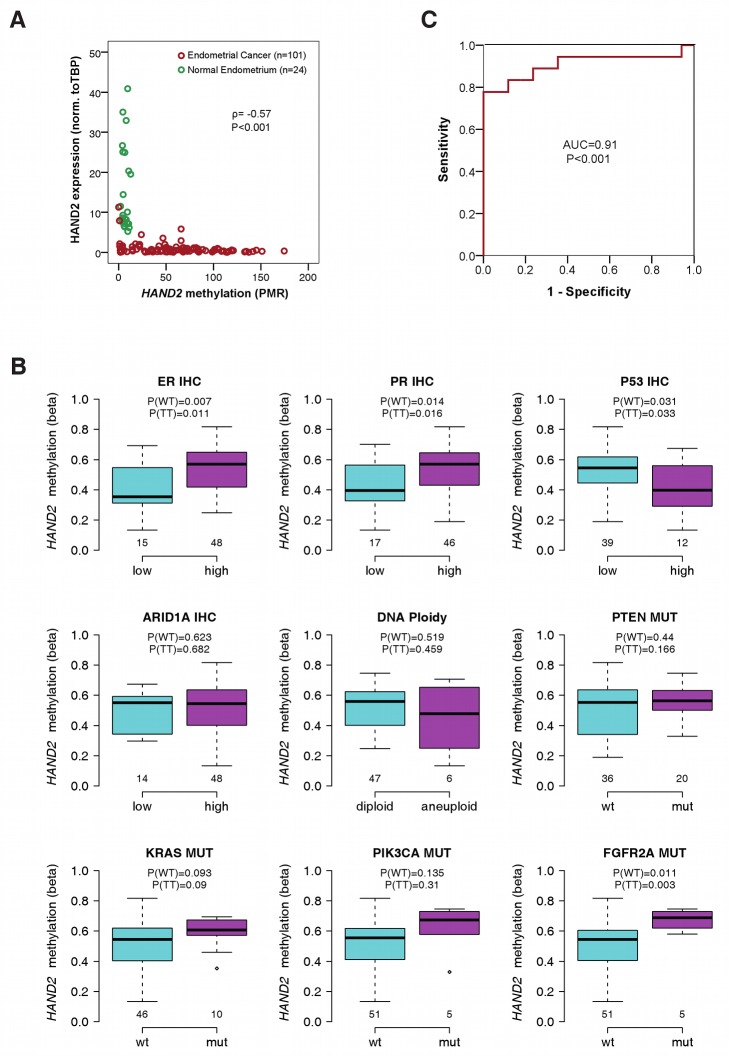
Association of HAND2 methylation with molecular and clinical features in invasive endometrial cancer.(A) Scatter plot of the MethyLight PMR profile and the gene expression profile of sample Set 3 showing 24 normal endometrium samples (in green) and 101 endometrial cancer samples (in red). The correlation between the two profiles was tested by the Spearman's rank correlation test with the correlation coefficient ρ and corresponding p-value (P). (B) Analysis of 34 molecular factors and association with HAND2 methylation (Set1; Table S12). The nine molecular cancer subgroups with significant heterogeneity between samples are displayed, and the p-values for the Wilcoxon rank sum test (WT) and t-test (TT) are provided separately. Boxes are median (interquartile range), and whiskers indicate range. (C) ROC curves measuring the sensitivity and specificity of HAND2 methylation in vaginal swabs to discriminate women with stage 1A endometrial cancer (n = 18) from women with non-cancerous causes (n = 17) for postmenopausal bleeding (Set 4). PMR values as continuous variables were used for the analysis. AUC and p-values (P) as specified. IHC, immunohistochemistry; mut, mutation.